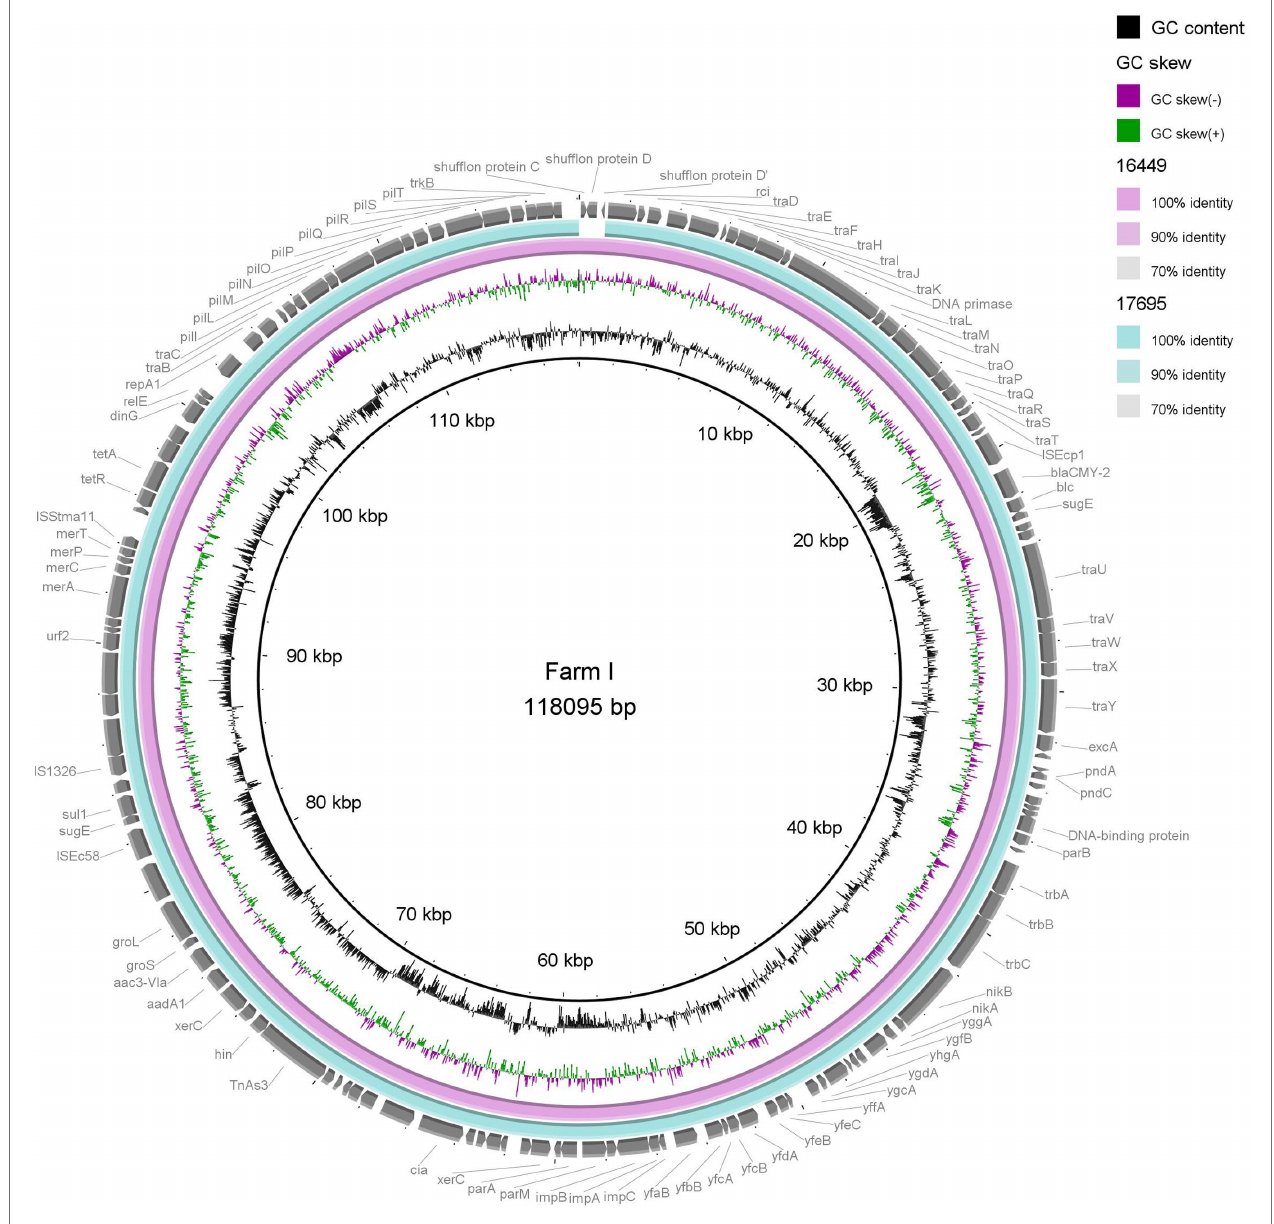
FIGURE 3 | Comparison of two IncK/ bla CMY-2 plasmids (117–118 kb) originating from extended-spectrum cephalosporin-resistant Escherichia coli of two different sequence types isolates from two different flocks on the same farm. Plasmid p16449 was used as